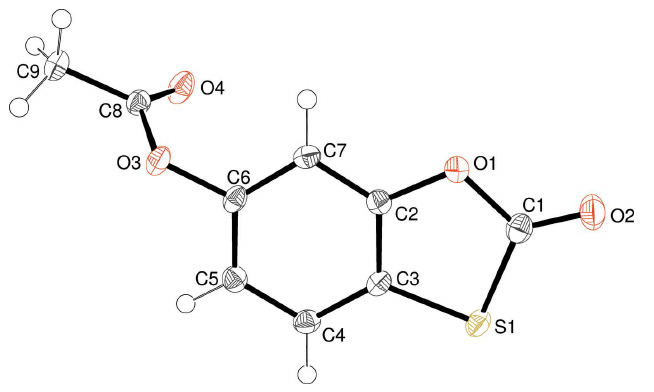
Figure 2 The molecular structure of (II), showing 50% displacement ellipsoids.